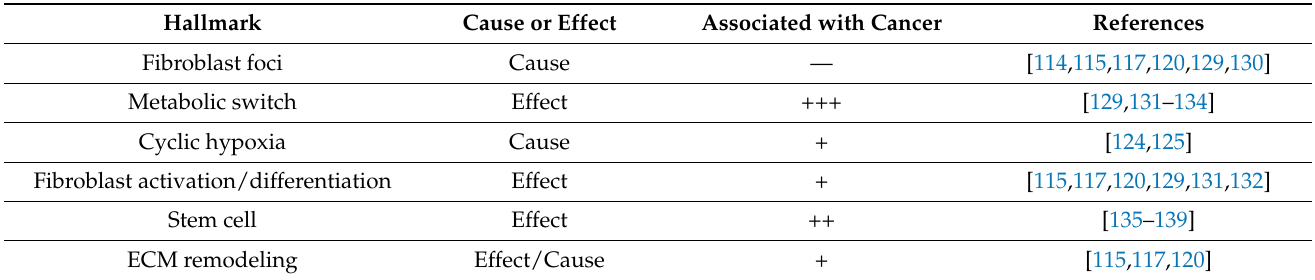
Table 2. Fibrosis hallmarks associated with